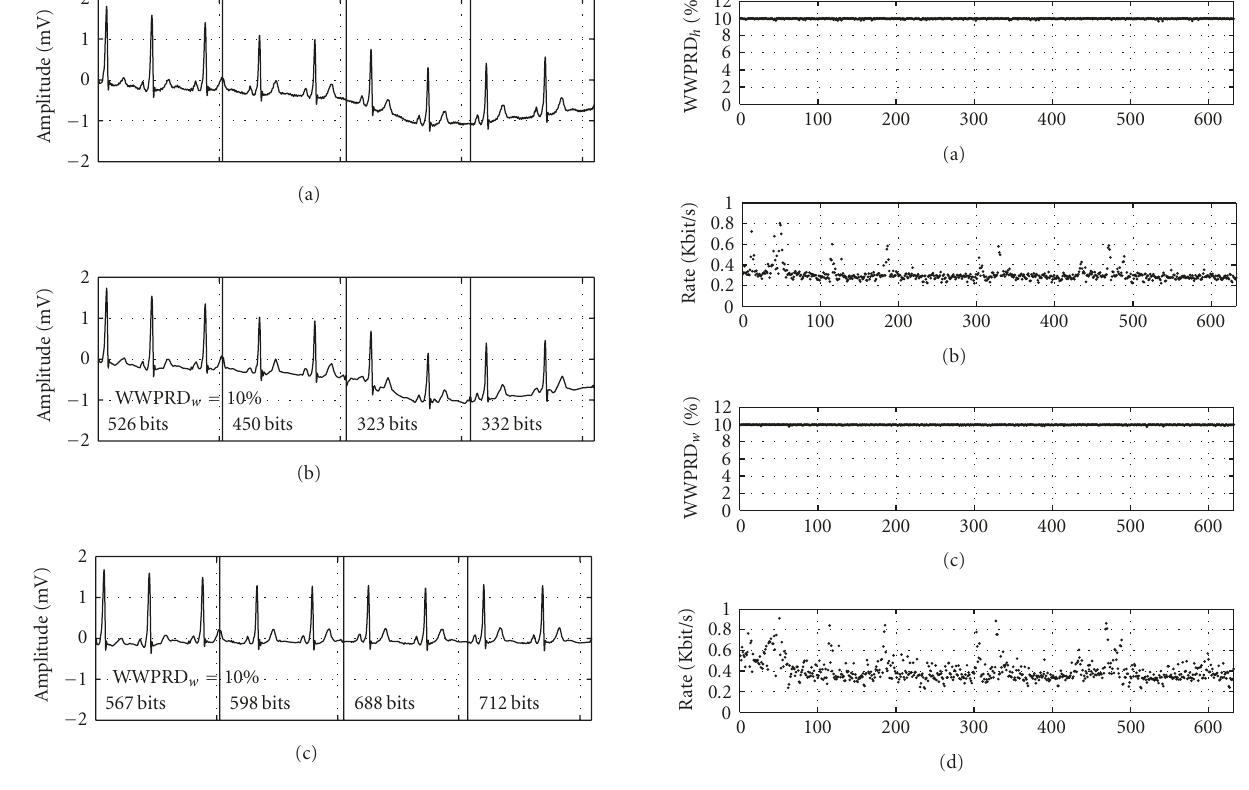
Figure 3: E ff ects on compression quality due to baseline wander- ing. (a) Original signal. (b) Reconstructed signal with baseline wan- dering. Target WWPRD w = 10%. (c) Reconstructed signal without baseline wandering. Target WWPRD w = 10%.